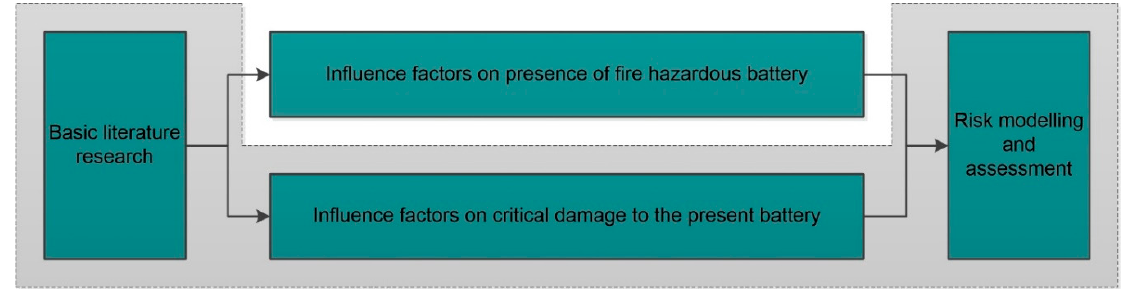
Figure 1. Overall approach and boundaries of this study (grey box).